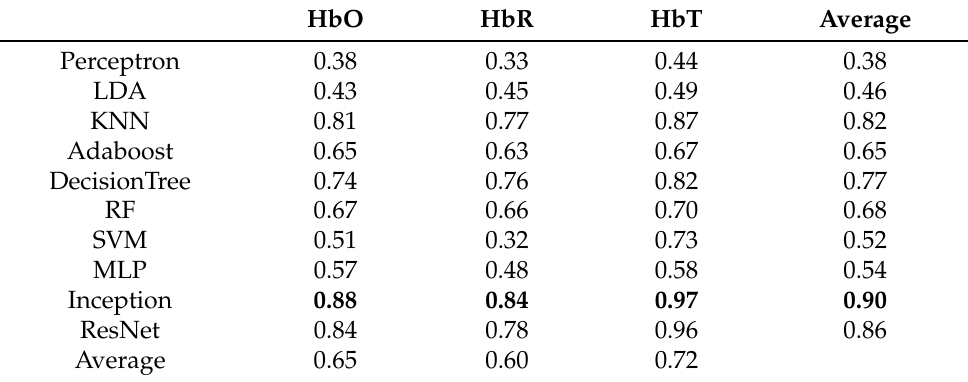
Table 2. Comparison results of different classification methods (traditional and deep learning) with three different hemodynamic matrices. The TSC method Inception achieved the best result in HbT matrix. HbO HbR HbT Average Perceptron 0.38 0.33 0.44